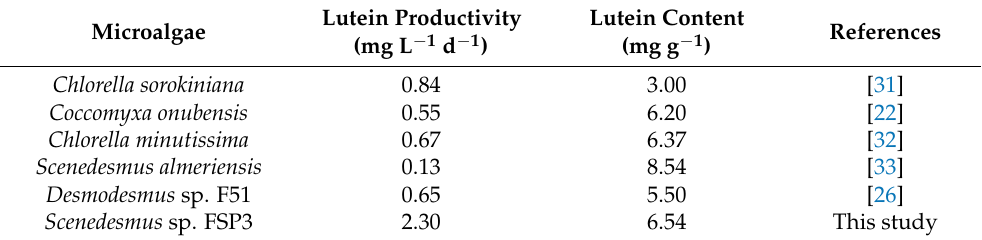
Table 2. The lutein production of Scenedesmus sp. FSP3 compared with other microalgal strains under autotrophic conditions from previous